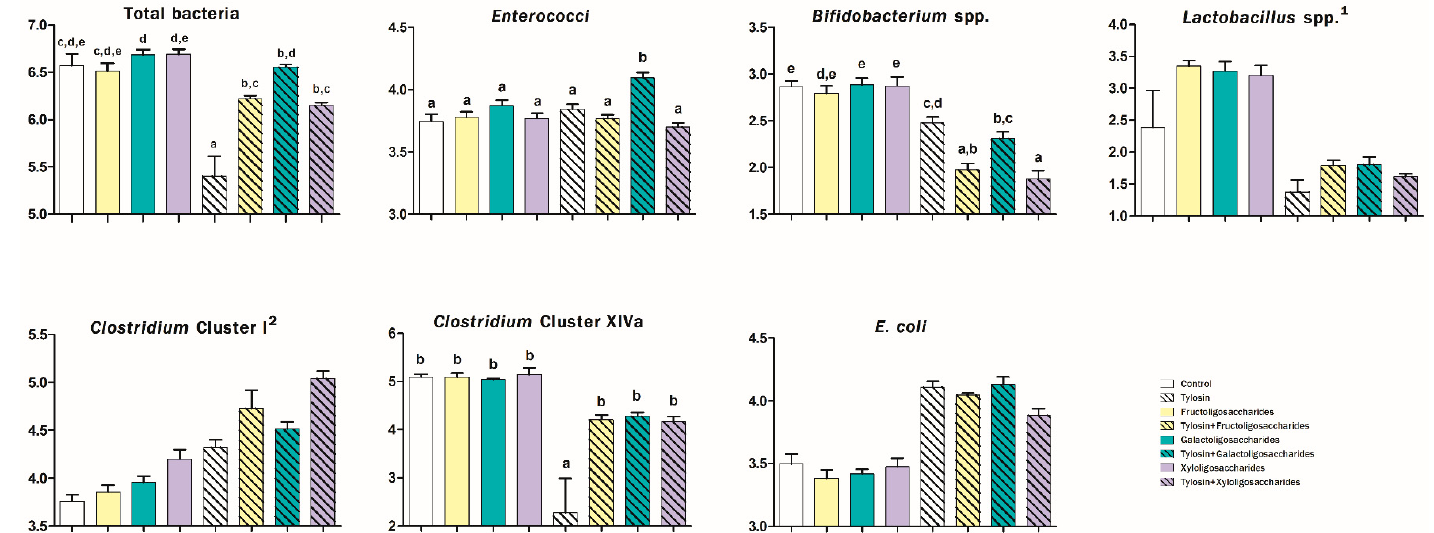
Figure 1. Microbial analysis (log 10 copies DNA/ng DNA) after 6 h of an in vitro incubation of canine fecal inoculum with a control diet supplemented with some prebiotics and/or tylosin tartrate. Values are the means of five bottles per treatment. According to Two-way ANOVA (Newman-Keuls test as post hoc): 1 fructooligosaccharides, galactooligosaccharides and xylooligosaccharides differ from control ( p < 0.05); 2 fructooligosaccharides differ from control ( p < 0.05); xylooligosaccharides differ from control ( p < 0.001). According to One-way ANOVA (Tukey’s test as post hoc): different letters indicate significant differences ( p < 0.05).